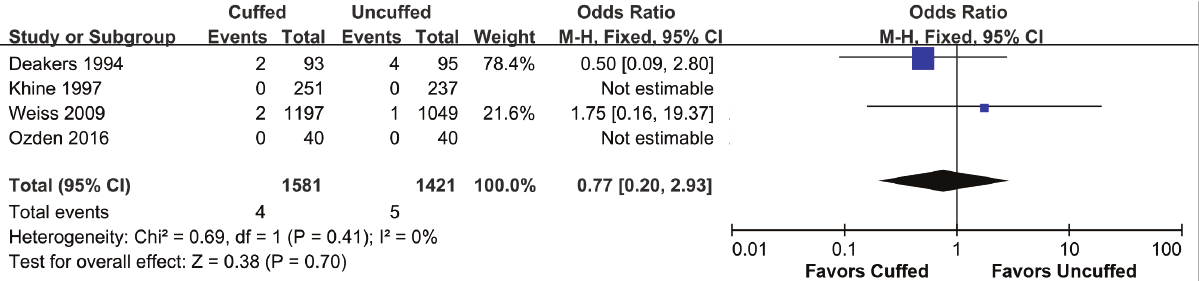
Supplemental Figure 3: The meta-analysis of tube reintubation between cuffed and uncuffed groups.